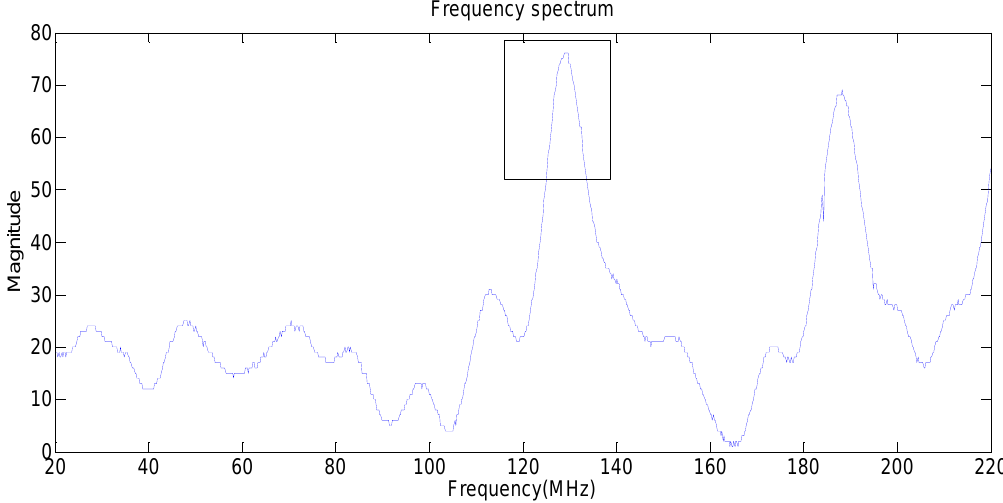
Figure 2. Power spectrum at 85 m using the center of gravity method based on the maximum value method.